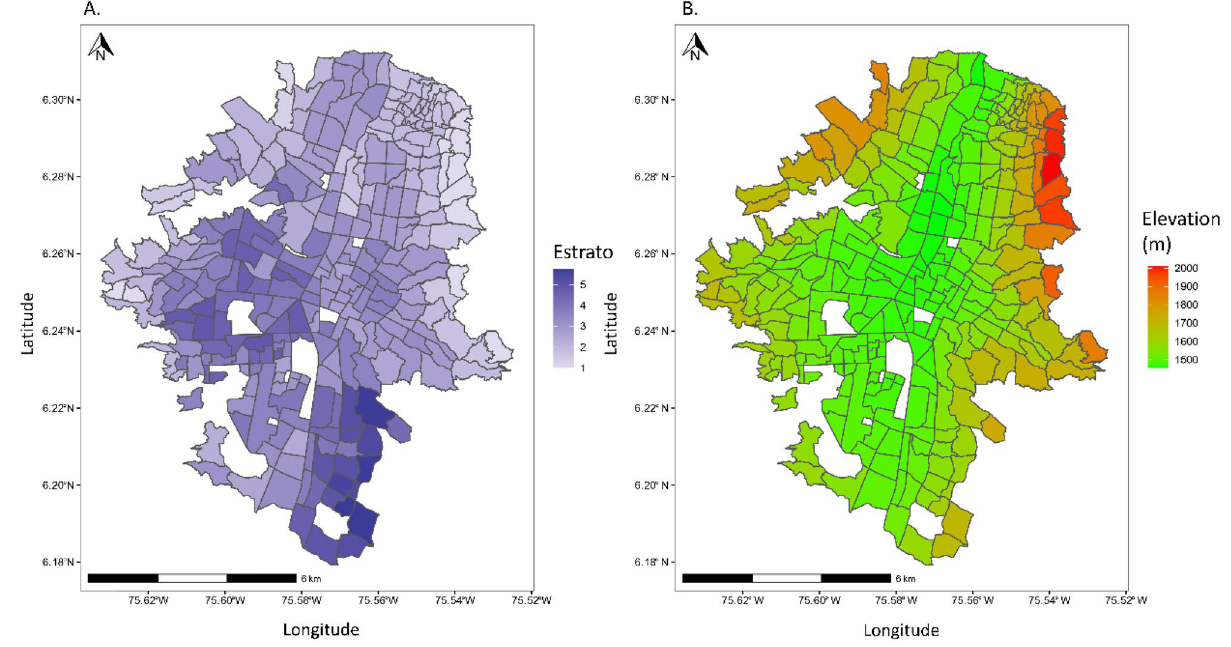
Figure 1. Maps of the transport zones of Medellín showing ( A ) mean socioeconomic status per zone, and ( B ) mean elevation per zone in meters. Blank zones are zones for which there was no data available. Socioeconomic status is measured as Estrato, a scale used for socioeconomic classification by the government of Colombia, measuring from 1 (lowest) to 6 (highest). Figure created in R (version 3.4.1) (R Core Team https:// www.R- proje ct.